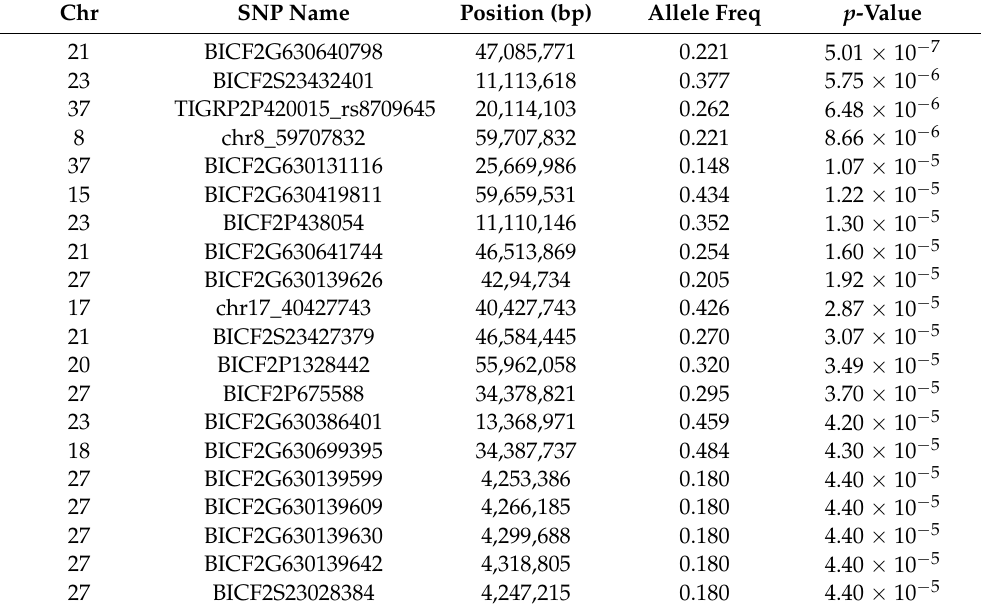
Table 5. Additional analysis (age of onset before 2 years of age) GWAS results showing chromosome (Chr), SNP name, position (bp), allele frequency, and raw p -value for the top twenty SNPs. One significant SNP was identified on chromosome 21. The interrupted line divides significant association from the rest. The significance threshold based on the Bonferroni correction was set to 5.8 × 10 − 7 . Chr SNP Name Position (bp) Allele